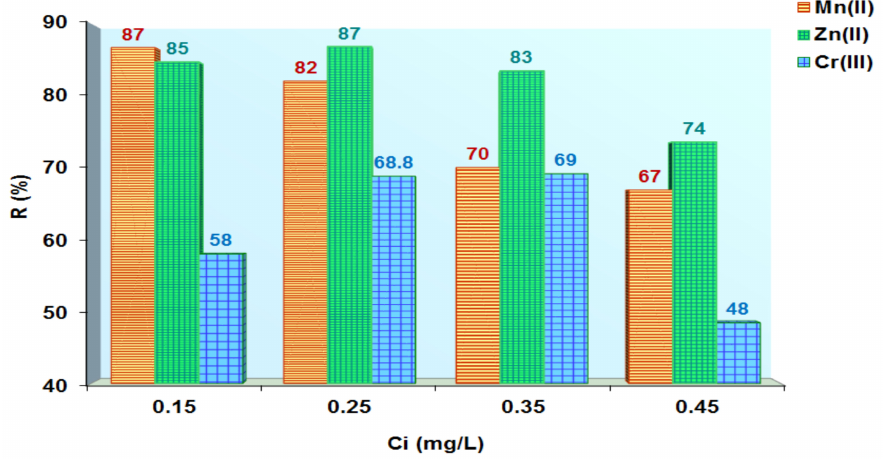
Figure 6. Metal ions removed from aqueous solutions using MS-AB 113.